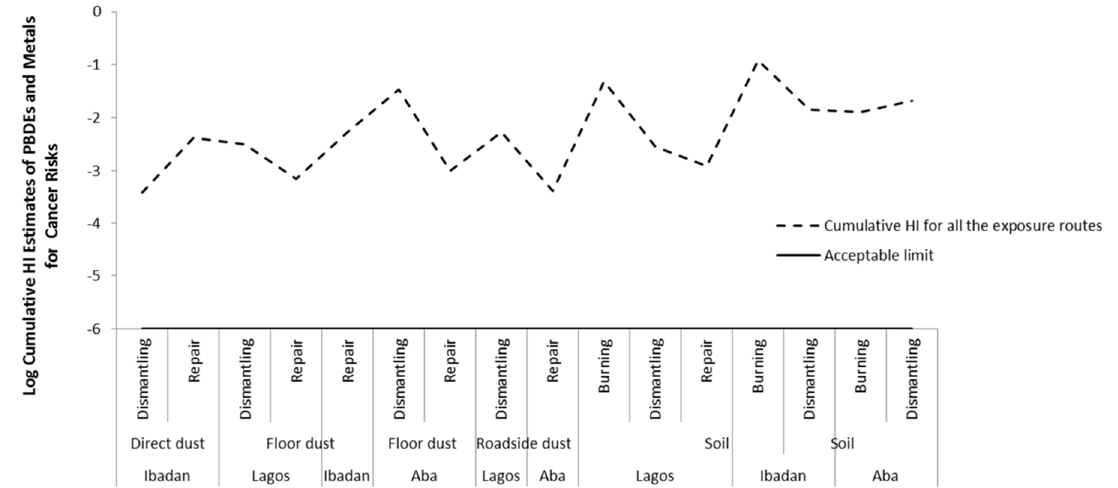
Figure 9. Cumulative Hazard index (HI) of all exposure routes for cancer risk of metal and Polybrominated Diphenyl Ethers (PBDEs) in soil and dust at various e -waste sites in the three locations.